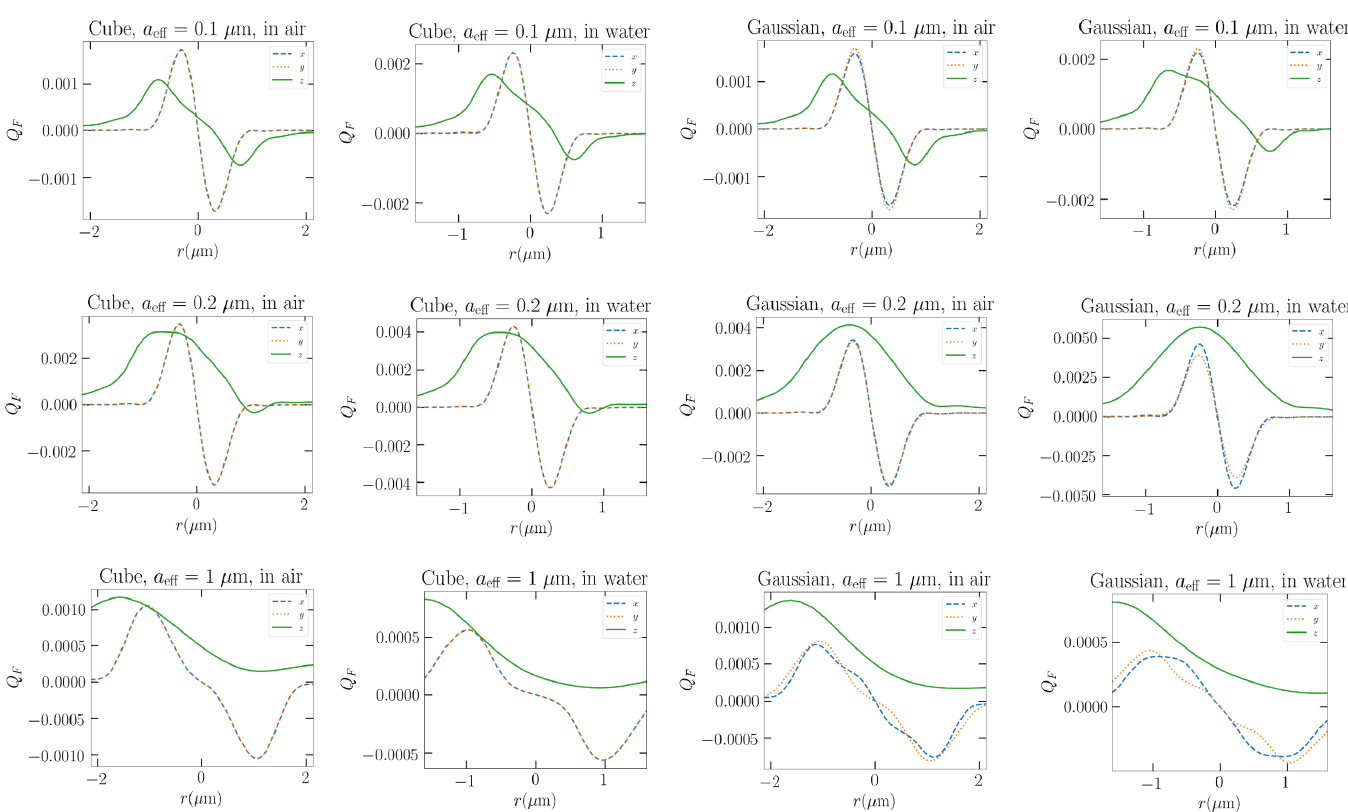
Fig 5. Trap efficiencies of different sized and Gaussian and cube particles in both water and air.